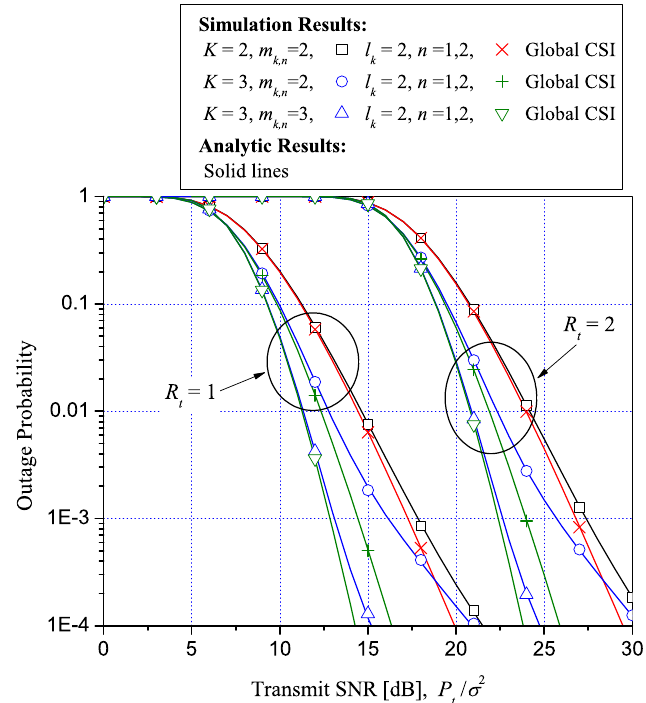
Figure 5. Outage probability for m k , n = 2,3, N k = 3, and l k = 2 for all k and n when K = 2,3 and R t = 1,2